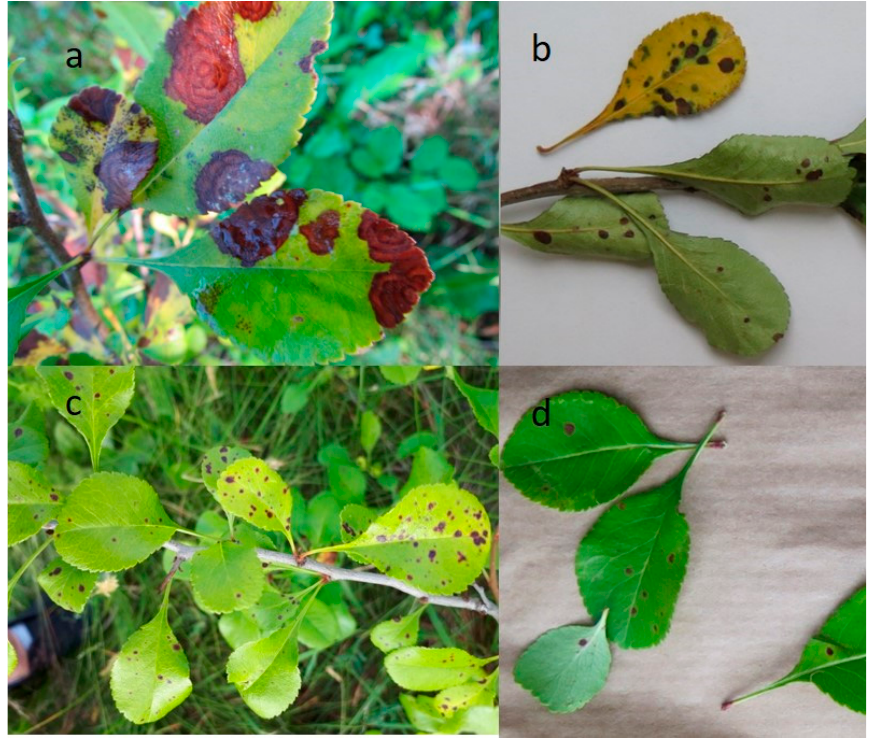
Figure 1. Various leaf spots on Japanese quince leaves: ( a ) brown irregular spots with concentric rings; ( b ) dark brown necrotic spots; ( c ) small dark spots with red halo; ( d ) small fuzzy